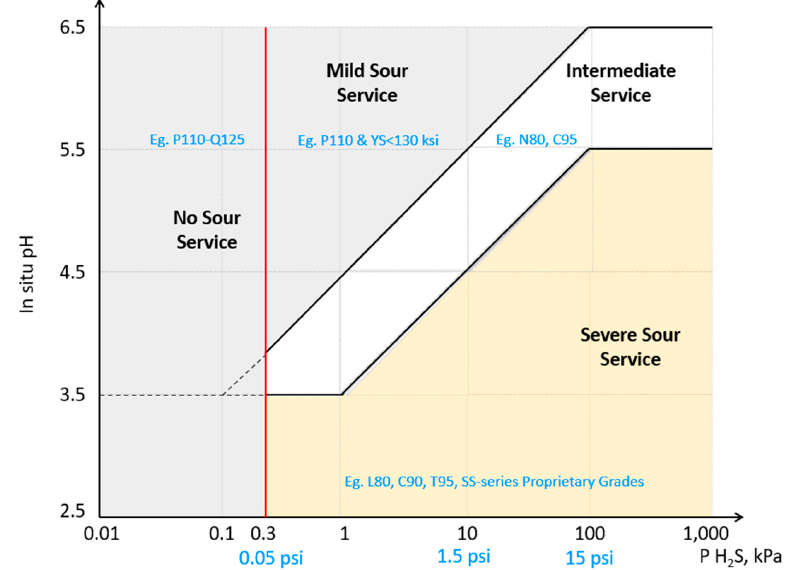
Figure 16. Steel materials for sour service [12].